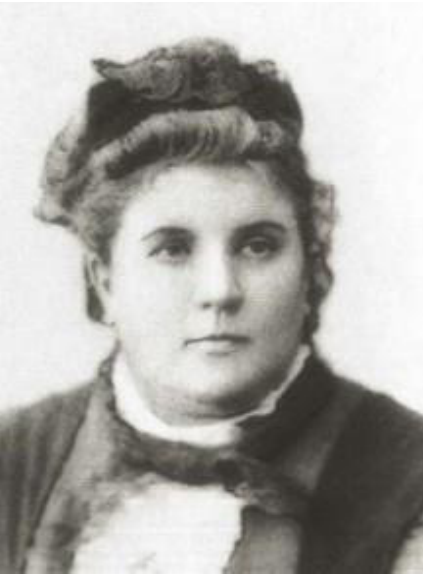
Figure 2. Anna Petrivna Vernadska (1837–1898), mother.